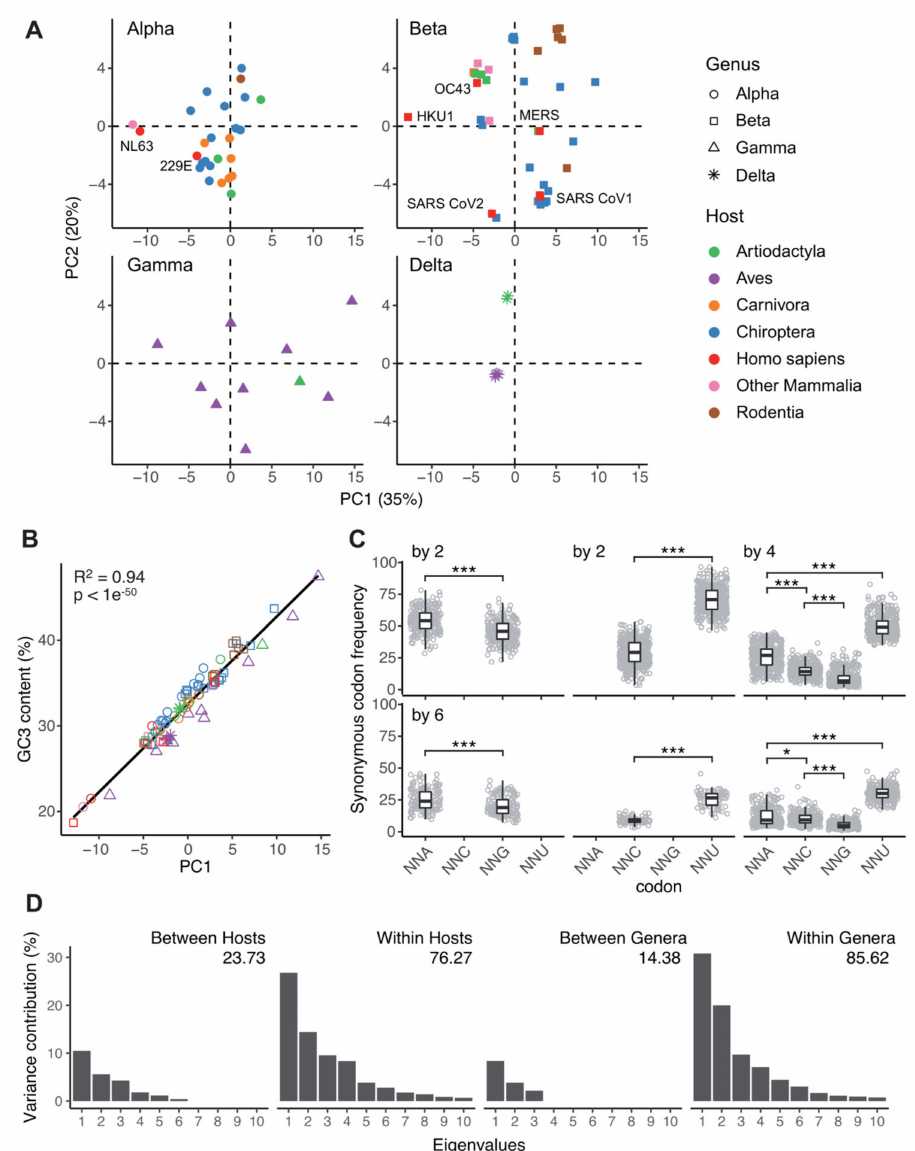
Figure 1. Variation in synonymous codon usage in Coronavirinae . ( A ) Principal component analysis of synonymous codon usage among CoVs. Each dot corresponds to an individual CoV, for which the frequencies of the 59 synonymous codons have been calculated. CoVs are stratified after the corresponding genera (Alpha-Delta), and host (color code in the inset). The percentage of the variance explained by the first and second axes is given in parenthesis. ( B ) Correlation between the projection on the first of principal components shown in ( A ) and the average GC-content at third codon position (GC3) for the corresponding viral genome. Symbols and color code are the same as in ( A ). The results for a Pearson’s correlation test are shown in the inset. ( C ) Synonymous codon usage frequency stratified by amino acids of multiplicity 2, 4, or 6 synonymous codons. Differences in median codon usage frequency values were assessed by a paired Wilcoxon signed rank test (code for p -value: * <0.05; ** <0.01; *** <0.001). ( D ) Results of an internal correspondence analysis for the contribution of the levels “viral taxonomy” (four levels, corresponding to viral genera) and “host taxonomy” (fourteen levels, corresponding to host orders) to explain variability among the eigenvalues of viral genomes on the first 10 principal components in the PCA shown in ( A ). The values for expected explanatory power for a homogeneous distribution were and 3.72% ( p -value < 9 × 10 − 4 ) for viral taxonomy and 7.59% ( p -value < 9 × 10 − 4 ) for host